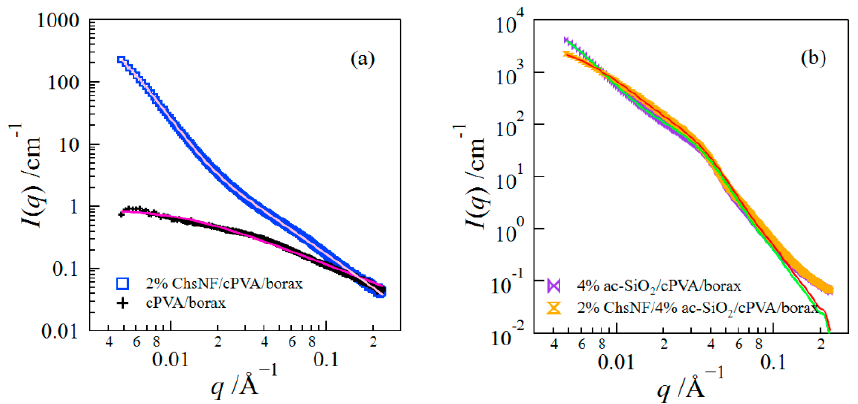
Figure 6. SAXS curves for cPVA/borax and ChSNF/cPVA/borax hydrogels ( a ), and for ac- SiO 2 /cPVA/borax hydrogels and ChsNF/ac-SiO 2 /cPVA/borax hydrogels ( b ).